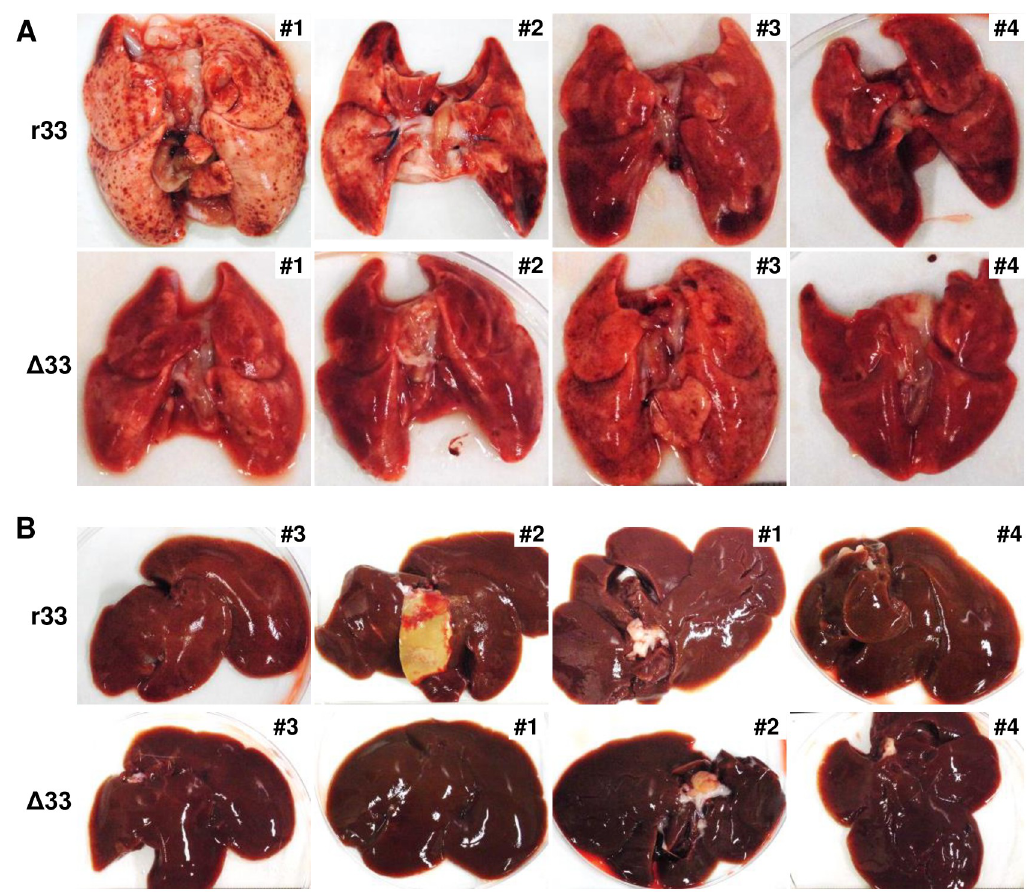
Fig 6. Appearance of the organs obtained from infected dams at 6 days p.i. Images of the lungs (A) and livers (B) obtained from the dams described in the legend for Fig 5 are shown in the order of abnormalities in appearance from most severe to